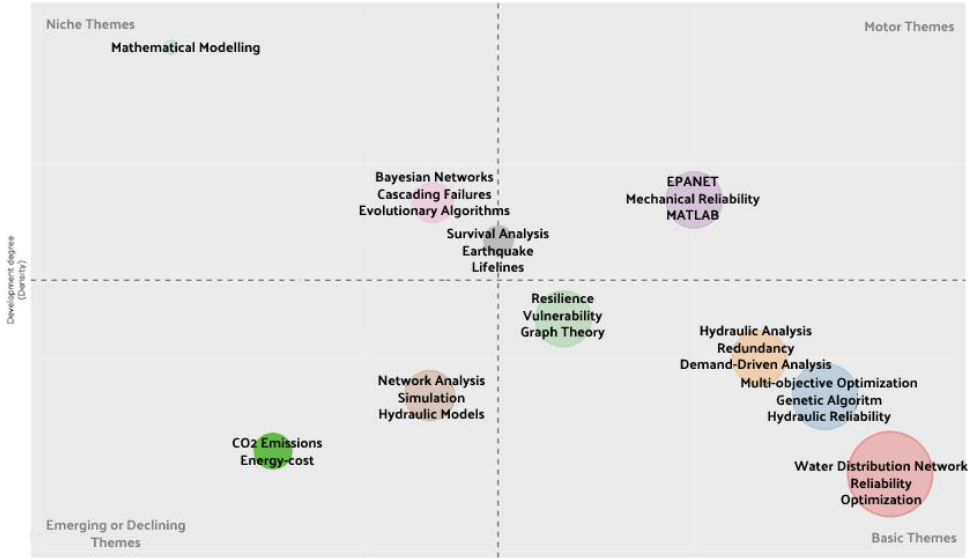
Figure 10. Thematic map based on author keywords. Node size represents the number of articles on a particular theme.